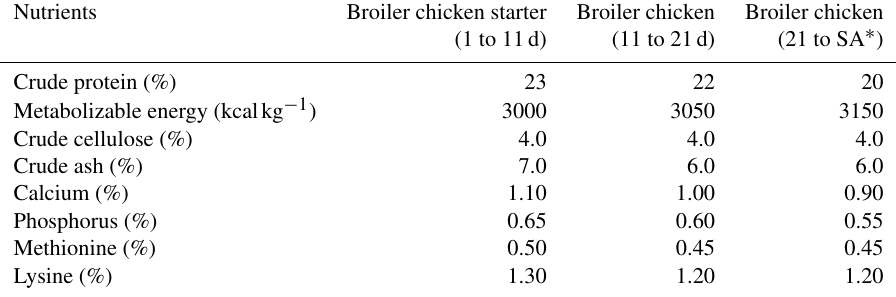
Table 2. Nutritional values of feeds used in the trials.